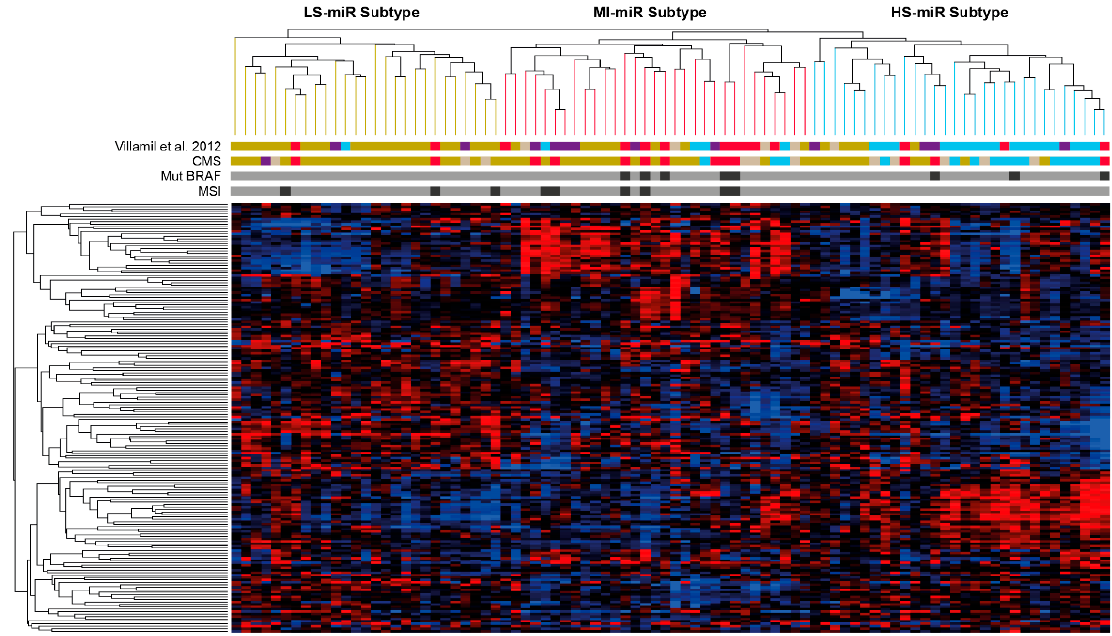
Figure 1. Molecular classification of tumors and miRs. Centered Pearson correlation and average- linkage-hierarchical clustering of the 88 tumor samples and 176 miRs in three miR tumor subtypes (miR-LS pistachio-green lines; miR-MI red lines and miR-HS light blue lines). Villamil et al. sub- types, CMSs, BRAF mutations and MSI are specified below the tree. Low-stroma-subtype/CMS2: pistachio green bar; mucinous-MSI-subtype/CMS1: red bar; high-stroma-subtype/CMS4: light blue; immunoglobulin-related: purple bar; unclassified samples: beige bar. Black bar: BRAF mutated and MSI; grey bar: BRAF wt and MSS. Heatmap intensities: 3.099 (red) to − 3.099 (dark